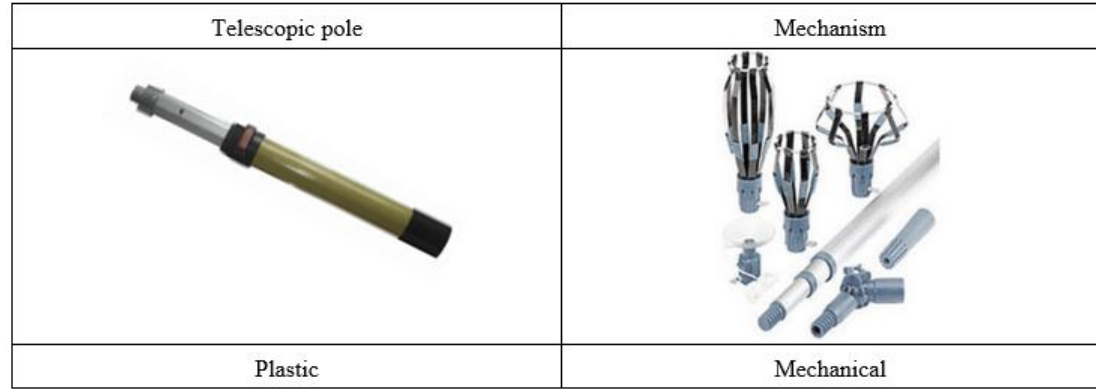
Figure 3. Telescopicpole material and mechanical mechanism